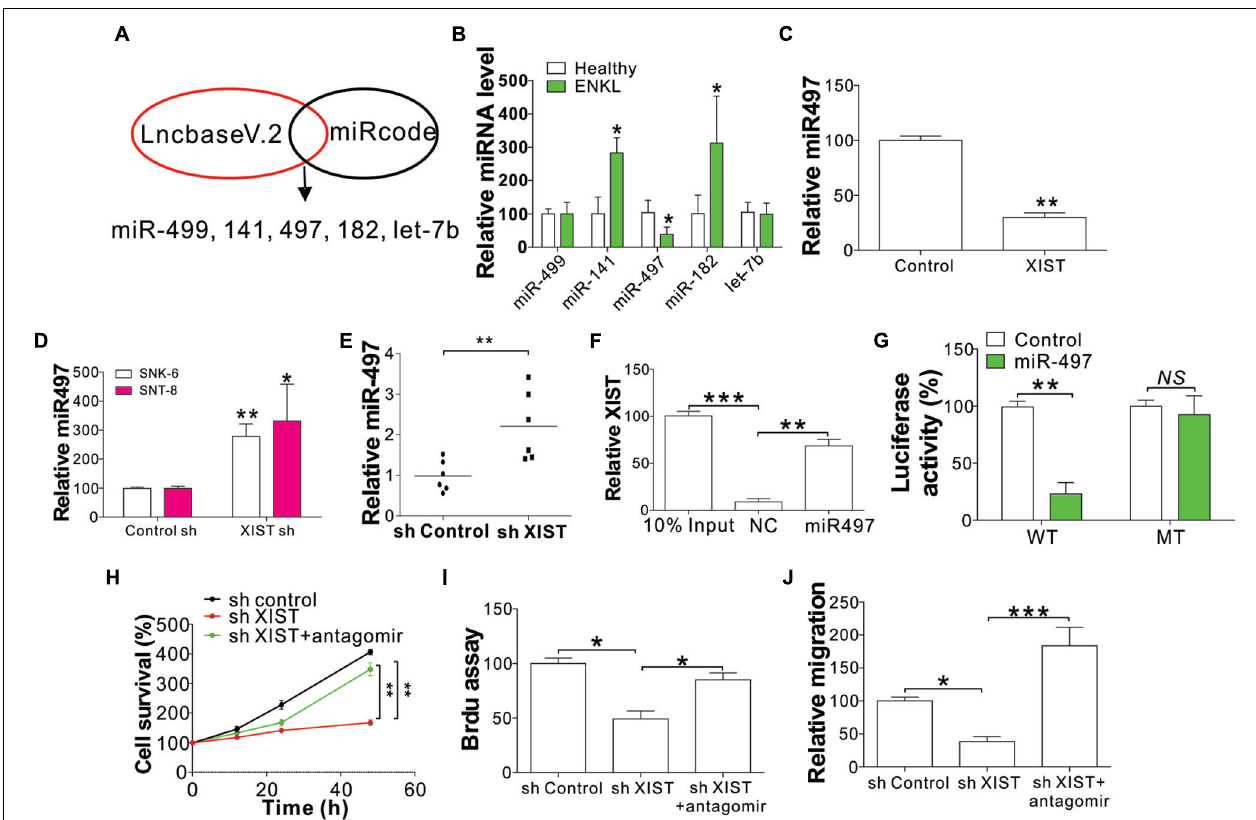
FIGURE 4 | XIST-mediated ENKL cell proliferation and migration following targeting of miR-497. (A) The process of search for XIST-targeting miRNAs. (B) The expression of indicated miRNAs in ENKL patients and healthy donors. (C) The expression of miR-497 in NK-92 cells stably expressing XIST. (D) The expression of miR-497 in SNK-6 and SNT-8 cells stably transfected with a control or XIST shRNA. (E) The expression of miR-497 in tumors of mice xenografted with SNK-6 stably transfected with a control or XIST shRNA ( n = 6). (F) The interaction of XIST and miR-497 analyzed via biotin-label miR-497 pull down. (G) The luciferase reporter activity of wild-type (WT) or mutant XIST fragment-constructed reporters with miR-497 co-transfection. The effect of miR497 on luciferase activity was normalized to control RNA transfection in each group. (H) The viability of SNK-6 cells with a stably transfected control or XIST shRNA in combination with the transfection of the miR-497 antagomir. (I) BrdU assay analysis of SNK-6 cells with a stably transfected control or XIST shRNA in combination with the transfection of the miR-497 antagomir. (J) Transwell assay analysis of SNK-6 cells with a stably transfected control or XIST shRNA in combination with the transfection of the miR-497 antagomir. Each experiment was repeated for 3 times. NS, p > 0.05; * p < 0.05; ** p < 0.01; *** p <